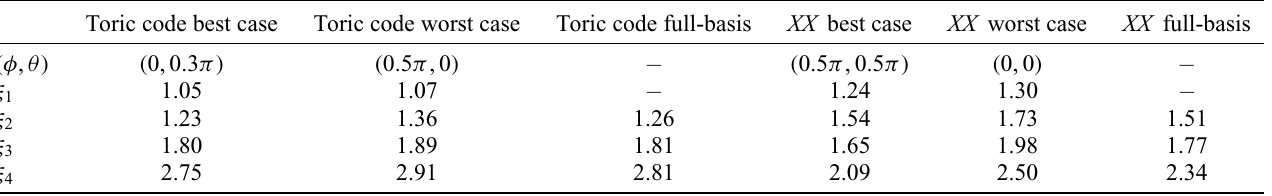
TABLE I. The extracted scaling factor defined in Eq. (33), ξ n , for n = 2, 3, 4 for the best and worst cases in the toric code ground state extracted from Fig. 9 and the XX model ground state. The scaling factors obtained in the full-basis method are displayed for comparison. The worst and best cases in ξ 1 are shown to predict well the dependence of ξ n on the basis choice. Toric code best case